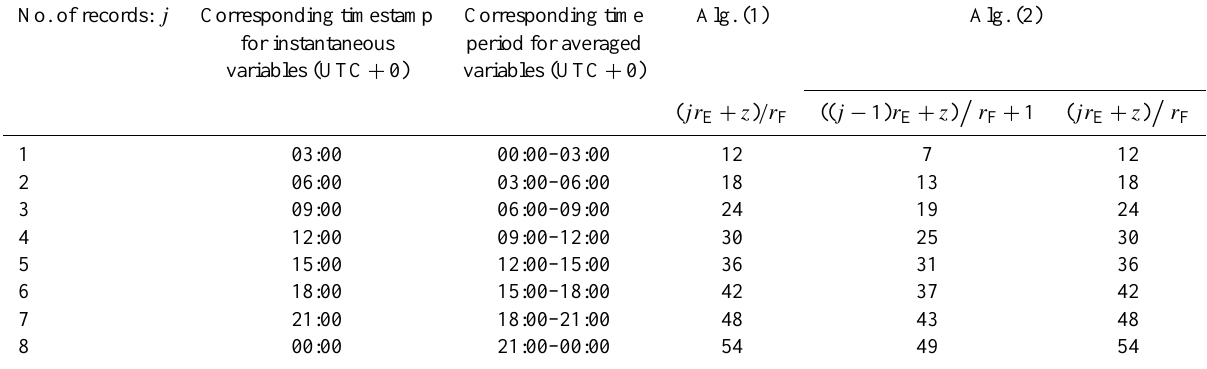
Table A1. Numerical application of the main equations used in the pseudo-algorithms based on the records from the ERA-Interim data set. No. of records: